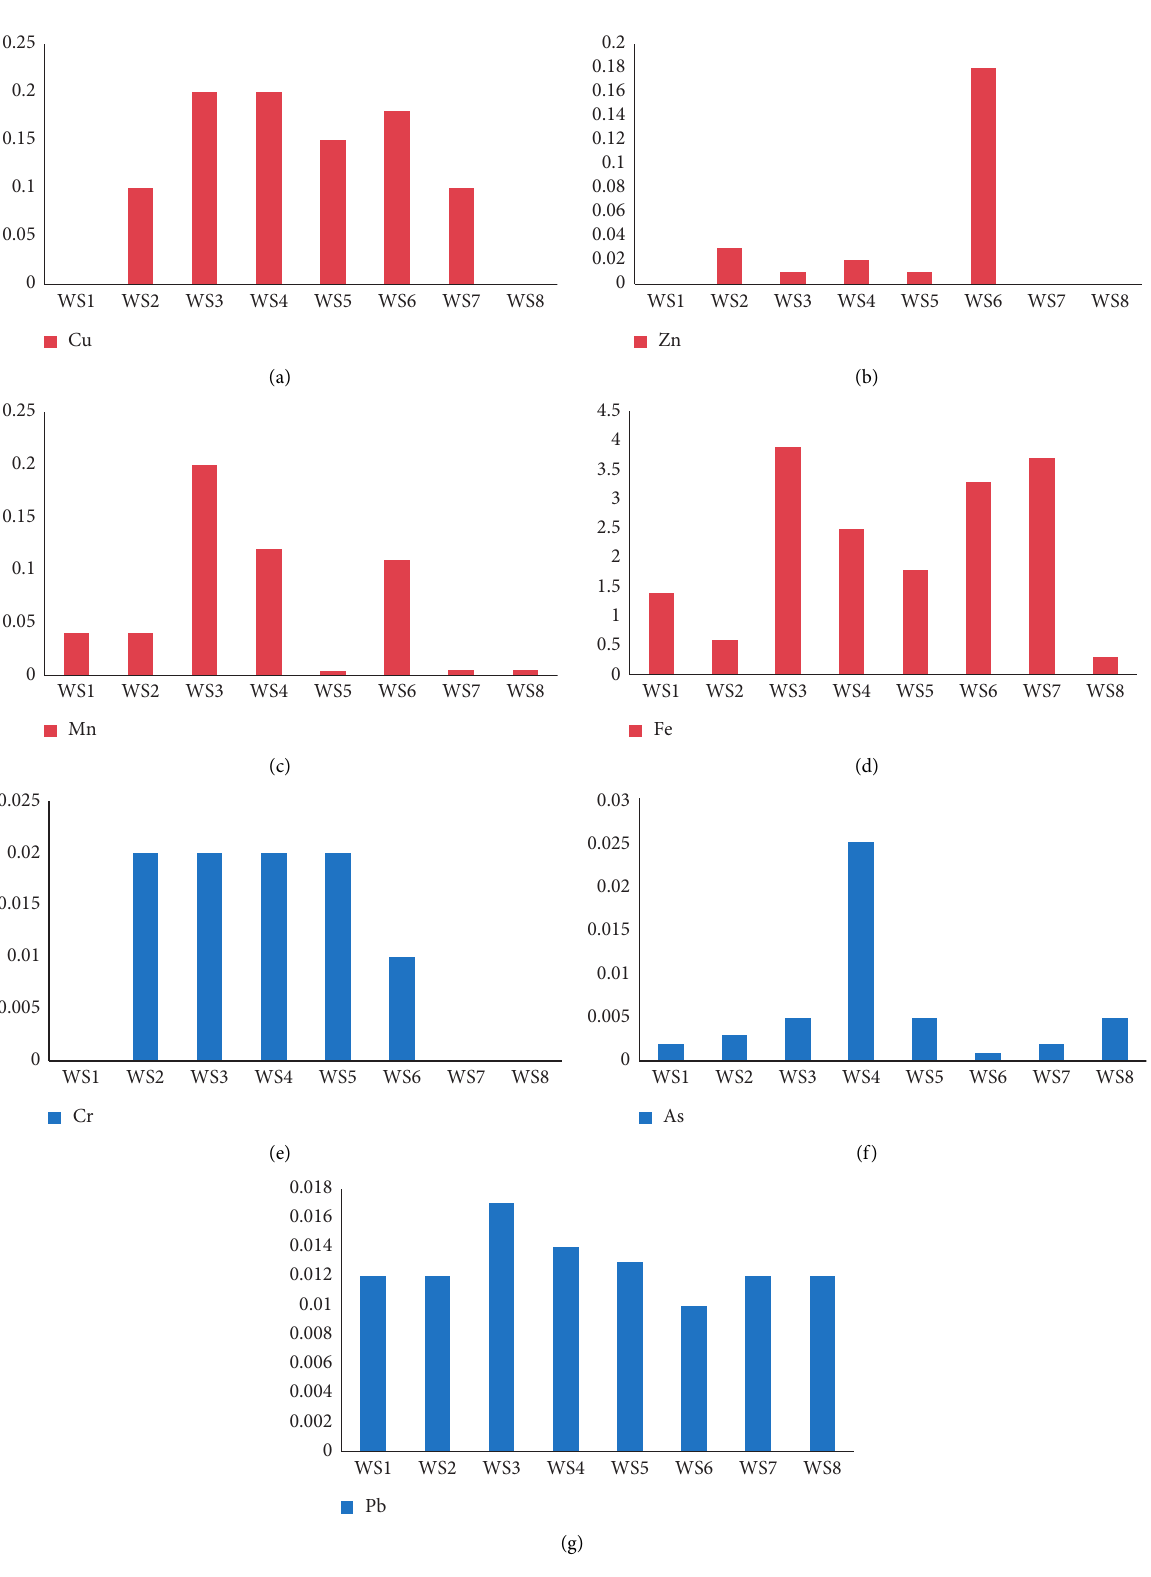
Figure 5: Spatial variations of heavy metals analyzed in water samples: (a) copper; (b) zinc; (c) manganese; (d) iron; (e) chromium; (f) arsenic; and (g)